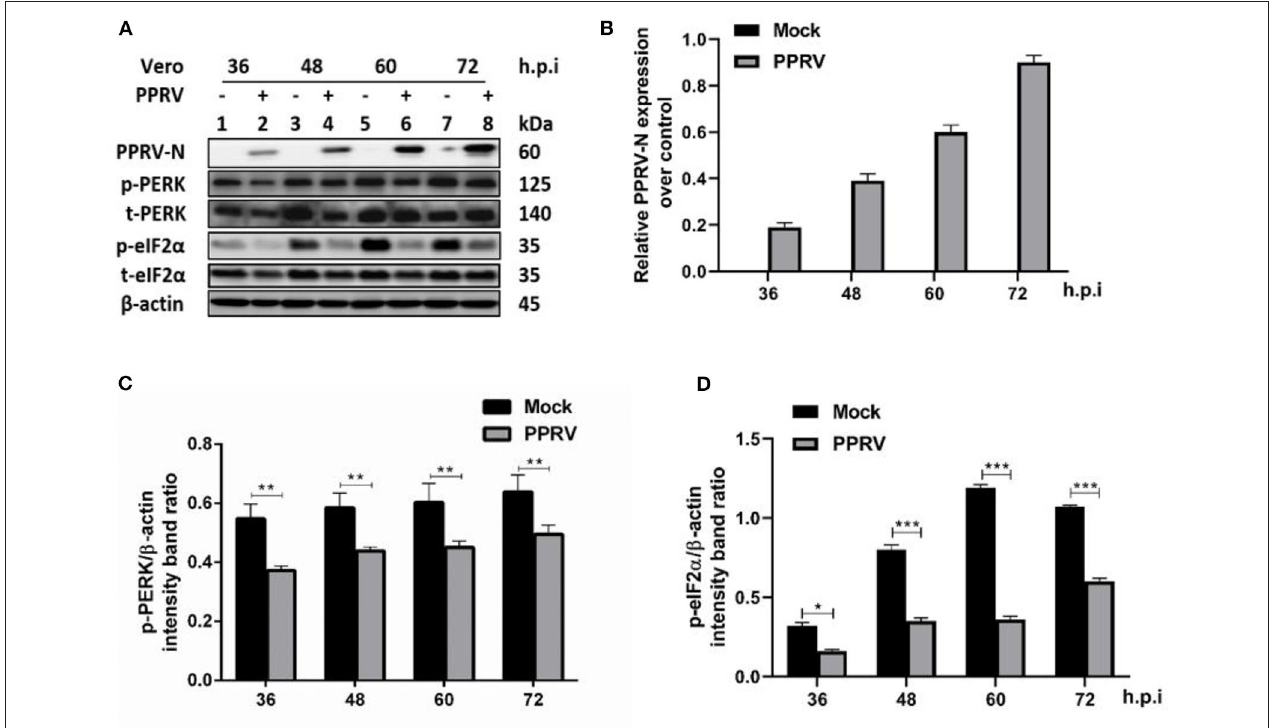
FIGURE 1 | PPRV infection inhibited eIF2 α phosphorylation in Vero cells. Vero cells were infected with PPRV or mock-infected. (A) The effect of PPRV on target proteins was analyzed by Western blot probed with specific antibodies. (B) Relative expression of PPRV in Vero cells over time was analyzed by Western blot probed with a mouse monoclonal anti-PPRV N. (C,D) Densitometry quantification of p-PERK and p-eIF2 α was normalized to β -actin and fold change was measured within each time point compared with mock-infected by ImageJ analysis. Statistical analysis was performed using GraphPad Prism 8.0 software. Shown are representative immunoblots and the error bars represent the mean ± SD from three independent experiments. The asterisks represent the statistically significant difference between mock and infected cells (* P < 0.5, ** P < 0.01, *** P <